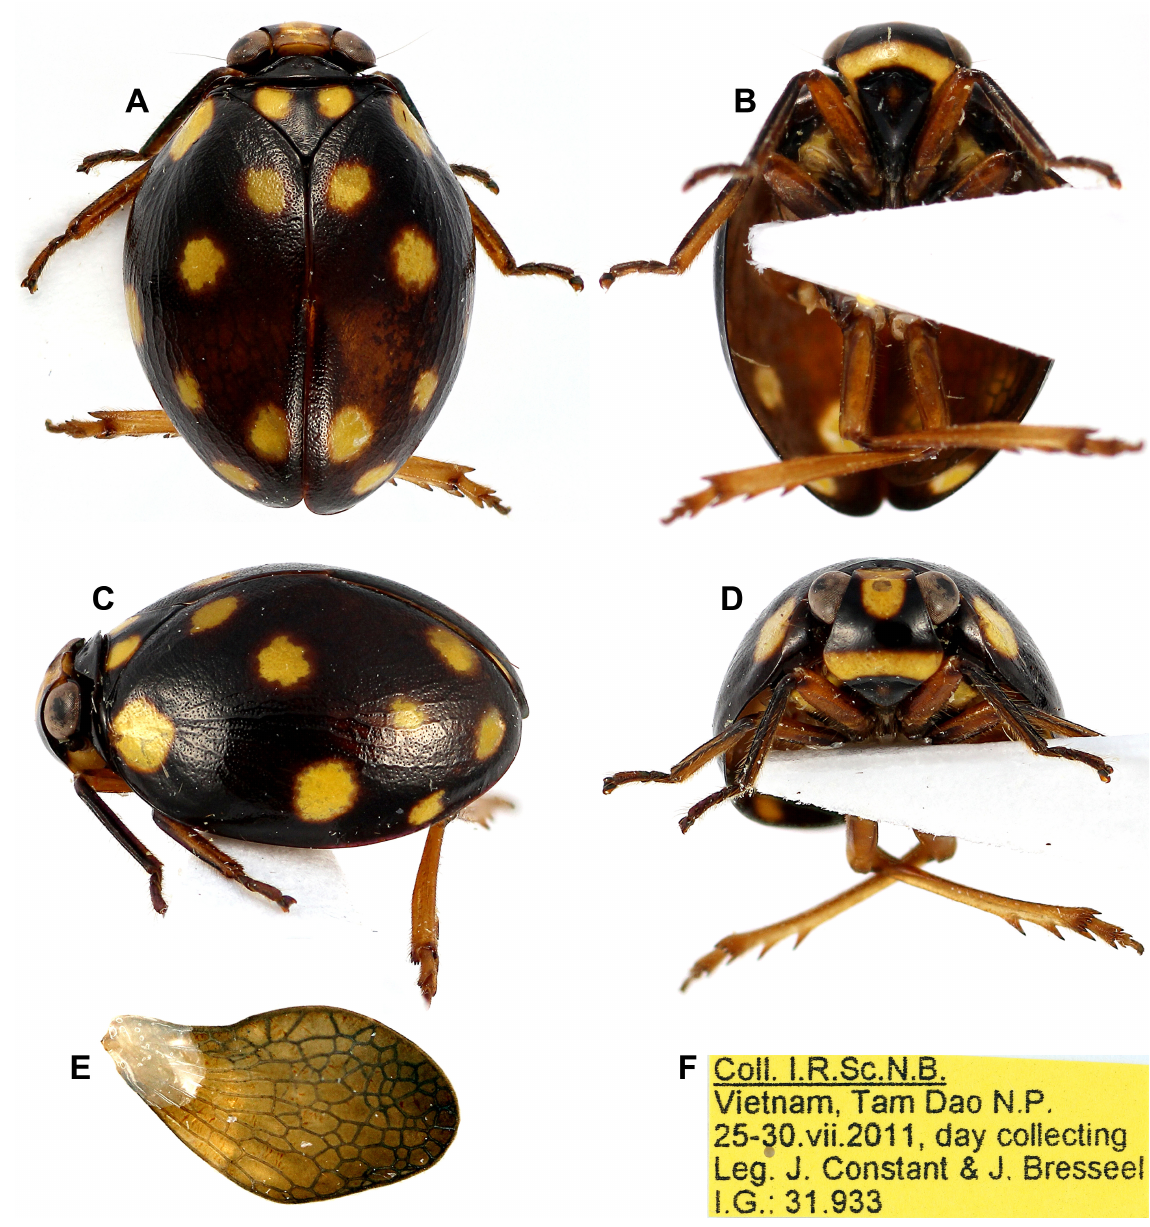
Fig. 3. Gergithus (Maculergithus) luteomaculatus subgen. et sp. nov., holotype, ♂, total length: 6.4 mm. A . Habitus, dorsal view. B . Habitus, ventral view. C . Habitus, lateral view. D . Habitus, frontal view. E . Right hind wing. F